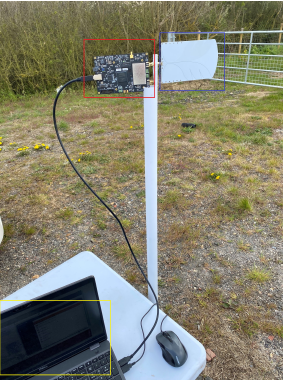
Figure 1. Experimental